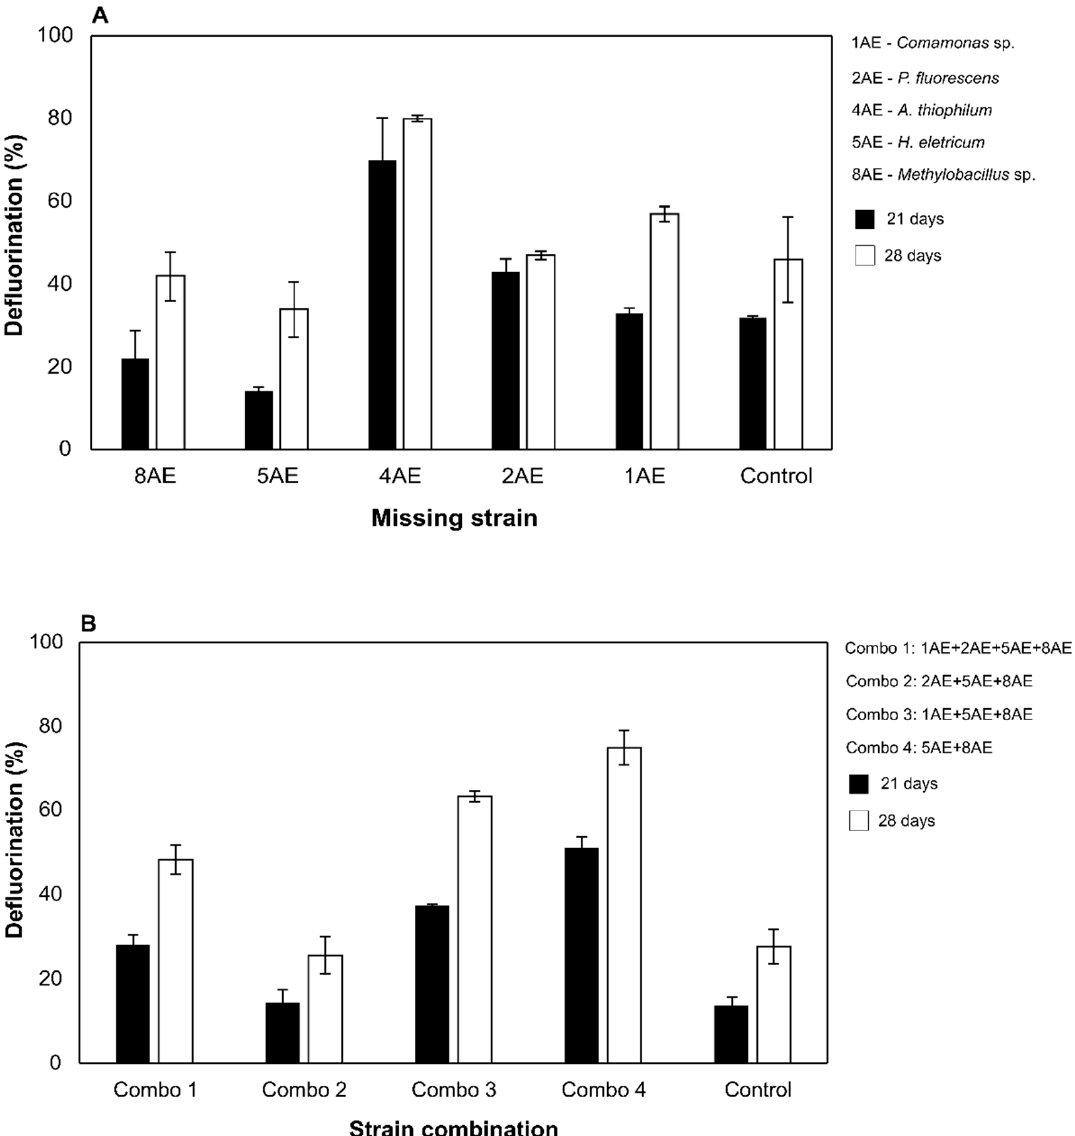
Figure 1. Results from the first ( panel A ) and second ( panel B ) optimization trials conducted with the bacterial strains isolated from the EPO-enriched consortium, after 21 and 28 days of incubation. Control cultures corresponded to a mixture of all bacterial isolates tested in both assays. Results are expressed as the mean of duplicates and bars represent the error.